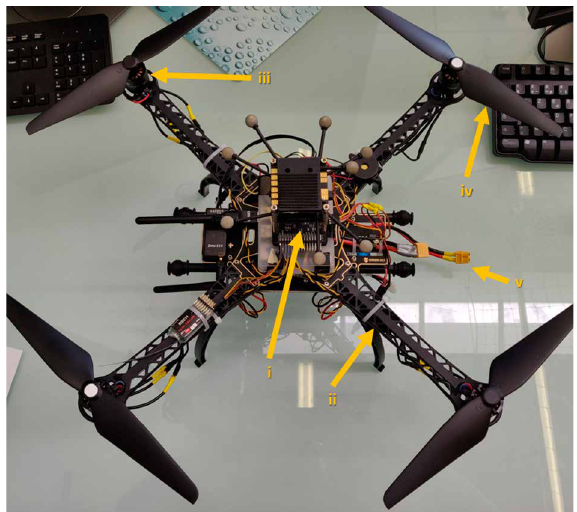
Figure 1: Multirotor in quad 𝑋 configuration with visible components of the propulsion chain. (i) Flight Controller, (ii) ESC (under arm), (iii) BLDC Motor, (iv) propeller, and (v) battery